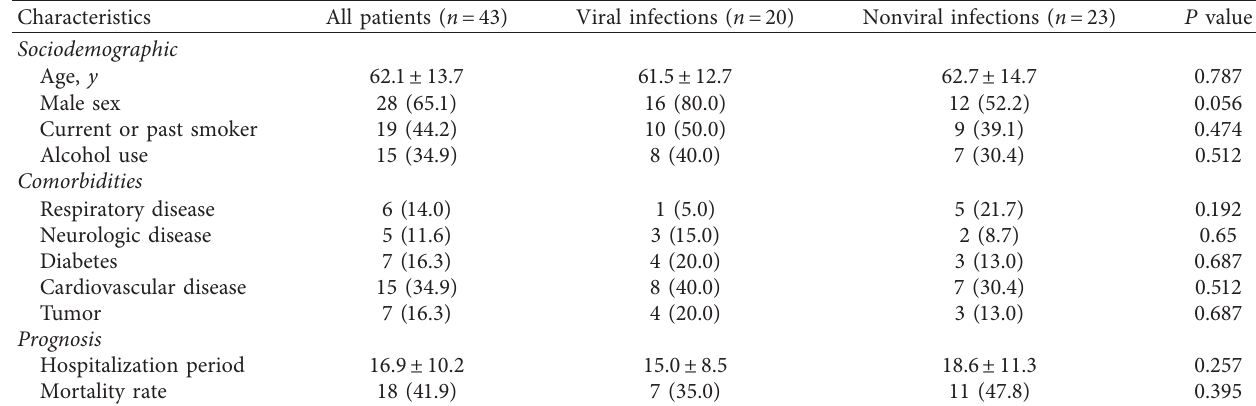
Table 1: Baseline characteristics of patients with viral and nonviral